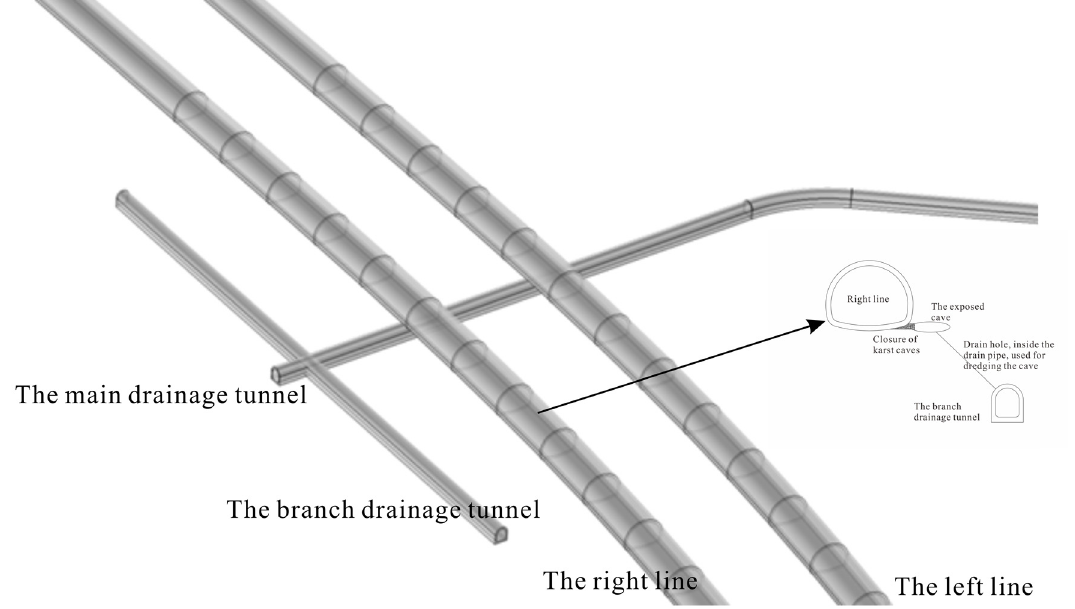
Figure 11. Schematic diagram of prevention and control measures for water inrush in tunnel.